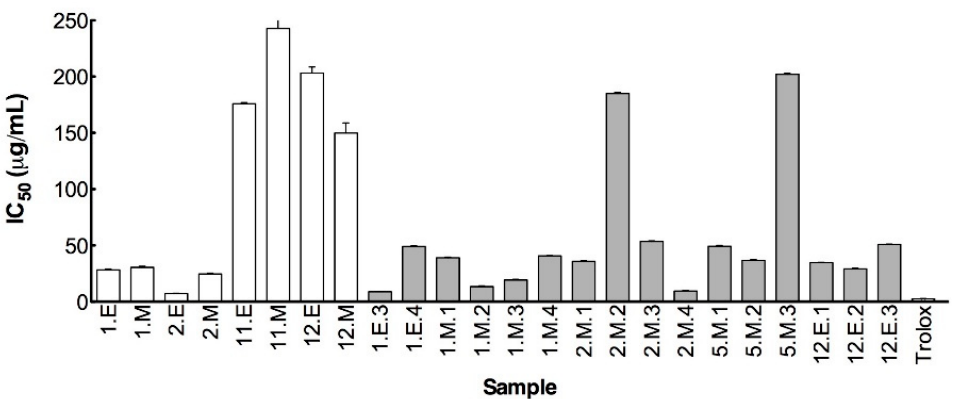
Figure 6. IC 50 values of ABTS radical scavenging activity by extracts (light bars) and fractions thereof (dark bars). Trolox was used as reference.